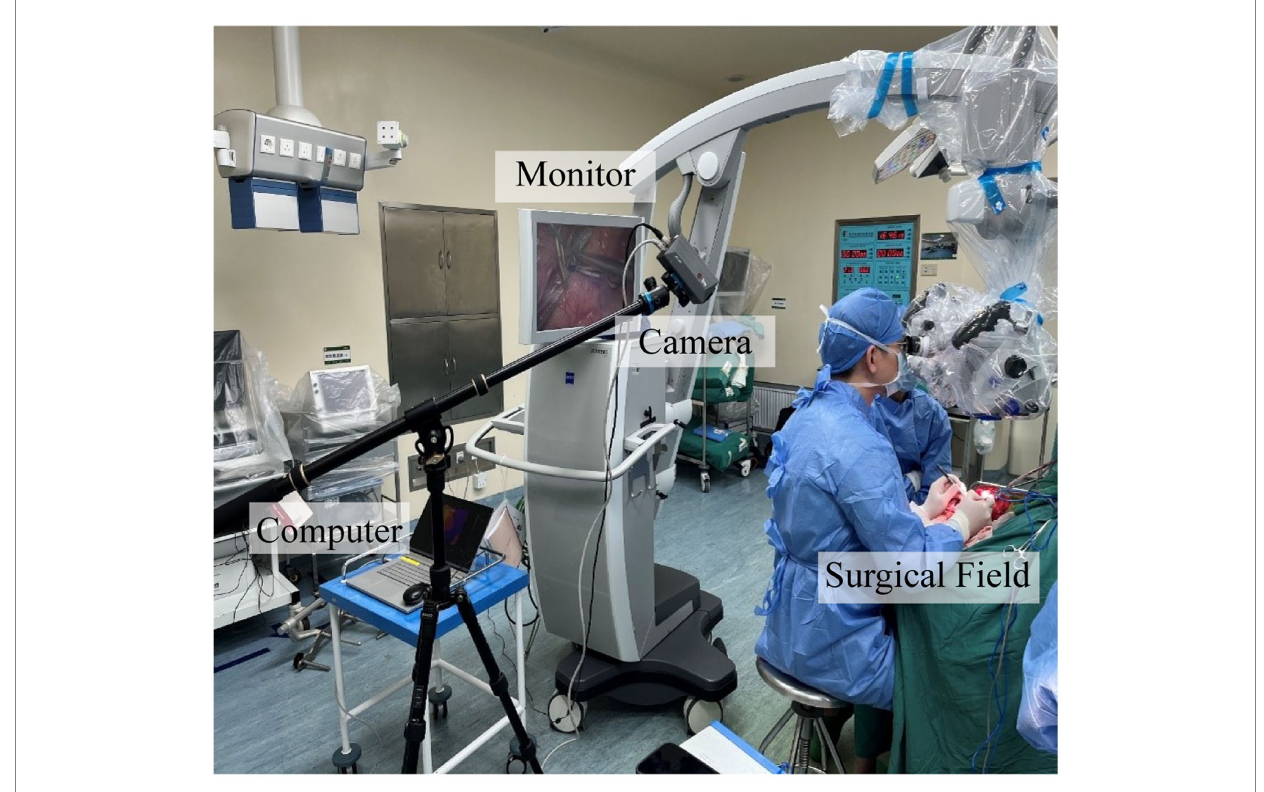
FIGURE 1 Photograph of the infrared imaging system in the operating